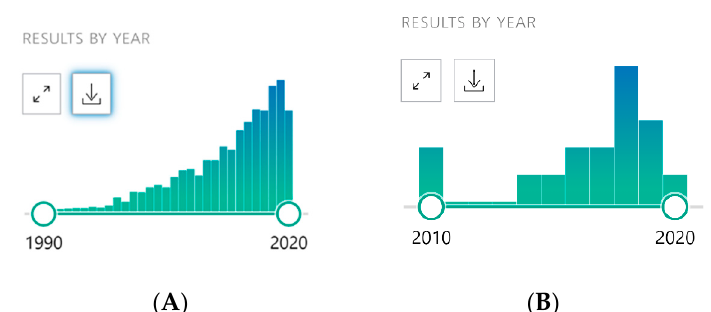
Figure 6. ( A )—Number of articles on PubMed: using the keywords “probiotic” and “lactic acid bacteria”, from 1995 to 2020. Data retrieved from https://pubmed.ncbi.nlm.nih.gov/?term=”probiotics+and+lactic+acid+bacteria”. of articles on PubMed: using the keywords “probiotics” and “ lactic acid bacteria “ and “wine”, data retrieved from